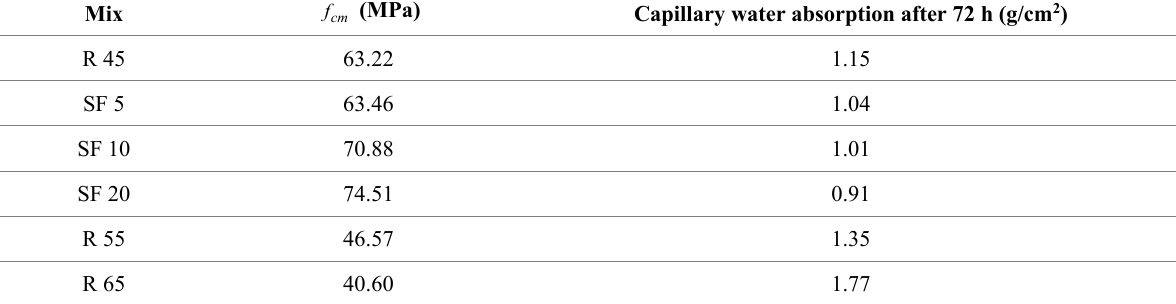
) and capillary water absorption of concretes. cm f